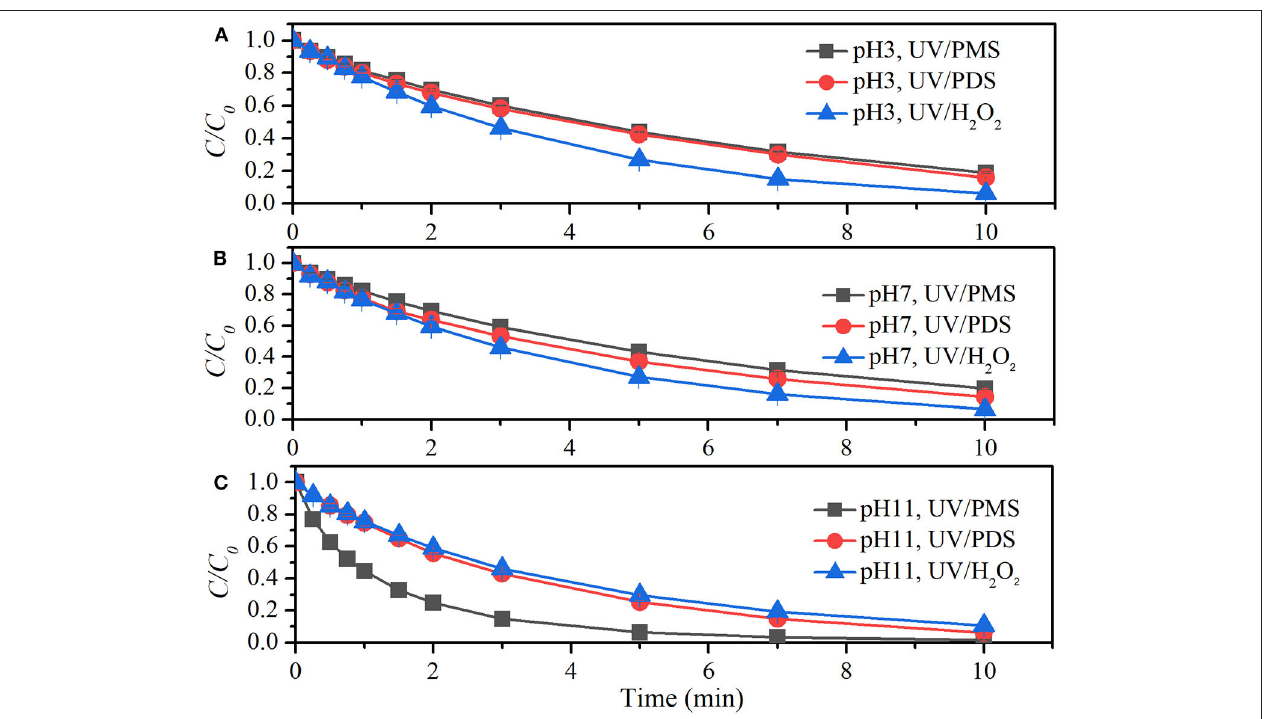
FIGURE 4 | Degradation efficiencies of BA by UV/PMS, UV/PDS, and UV/H 2 O 2 (A) at pH 3, (B) at pH 7, and (C) at pH 11. Conditions: 0.6L, I 0 = 1.7 × 10 − 6 Einsteins · s − 1 , [PB] = 2mM, [BA] = 9.0 µ M, [PMS] = 100 µ M as 1/2 Oxone, [PDS] = 100 µ M, [H 2 O 2 ] = 100 µ M, 25 ◦ C.